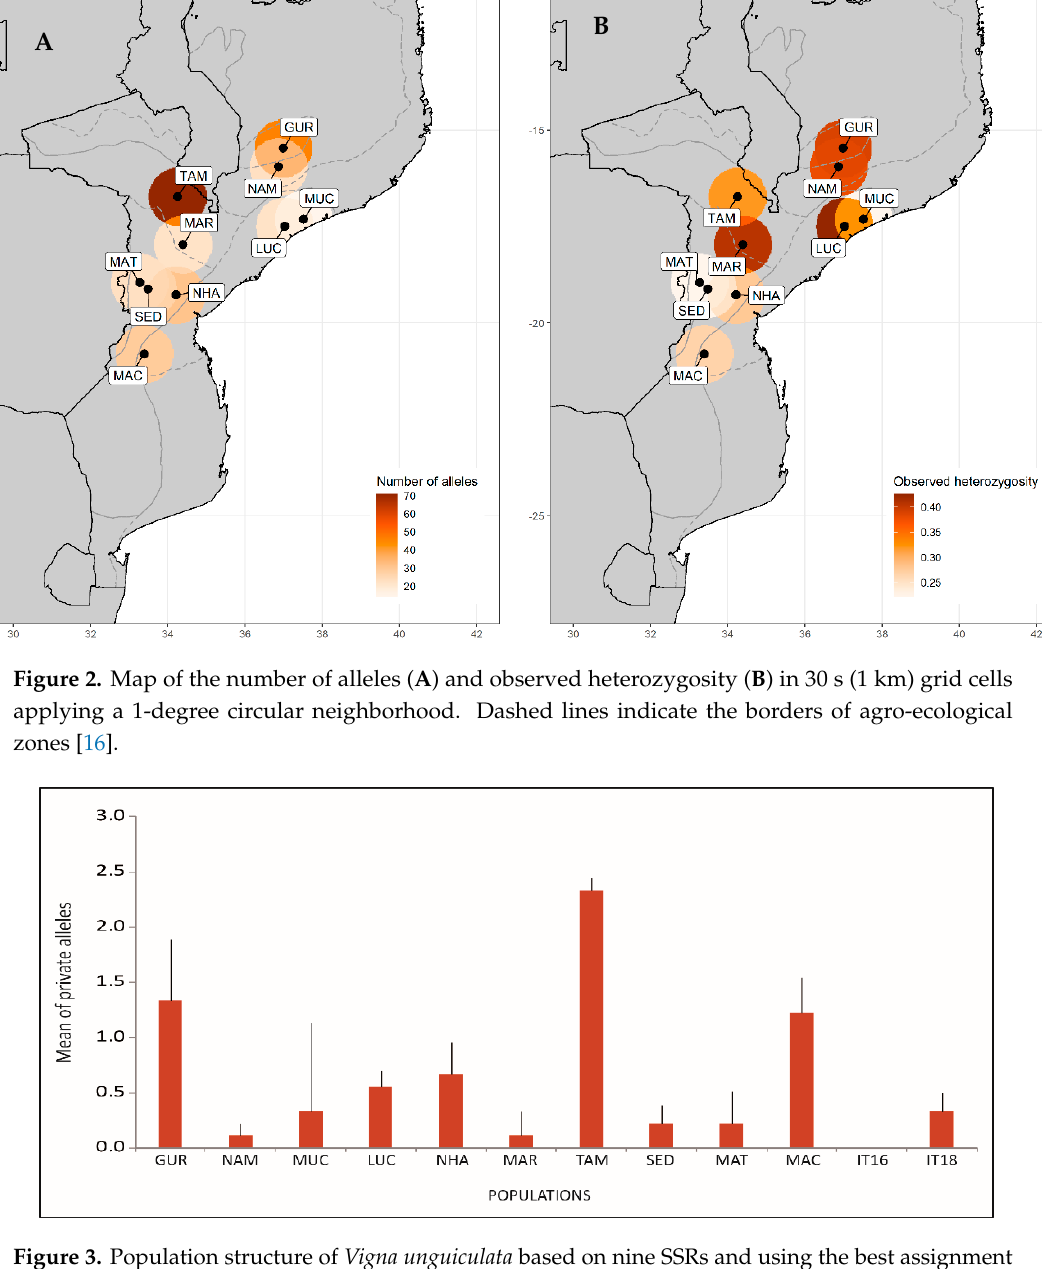
Figure 3. Population structure of Vigna unguiculata based on nine SSRs and using the best assignment result retrieved by STRUCTURE ( K = 4). Each individual sample is represented by a thin vertical line divided into K colored segments that represent the individual’s estimated membership fractions in the K cluster. Distribution of private alleles among the different landraces of Vigna unguiculata . Landraces code follows Table 2. The two cultivars are also indicated.